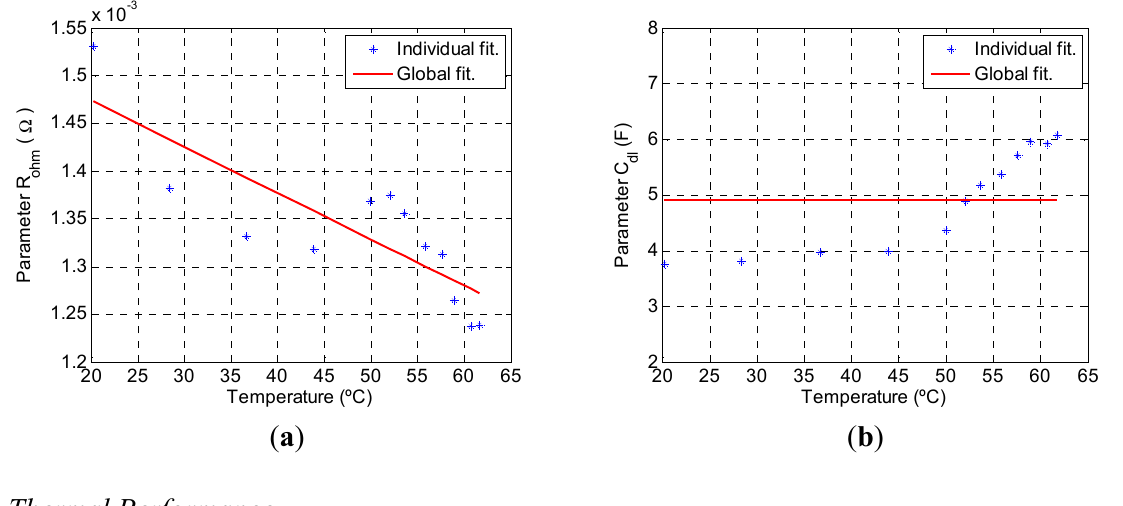
Figure 8. Results of the individual fit for each temperature and the global fit based on the temperature of the ohmic parameters ( a ) and double layer parameters ( b ) for the FC electrical model for a temperature range from 20 to 62 °C Individual fit. Global